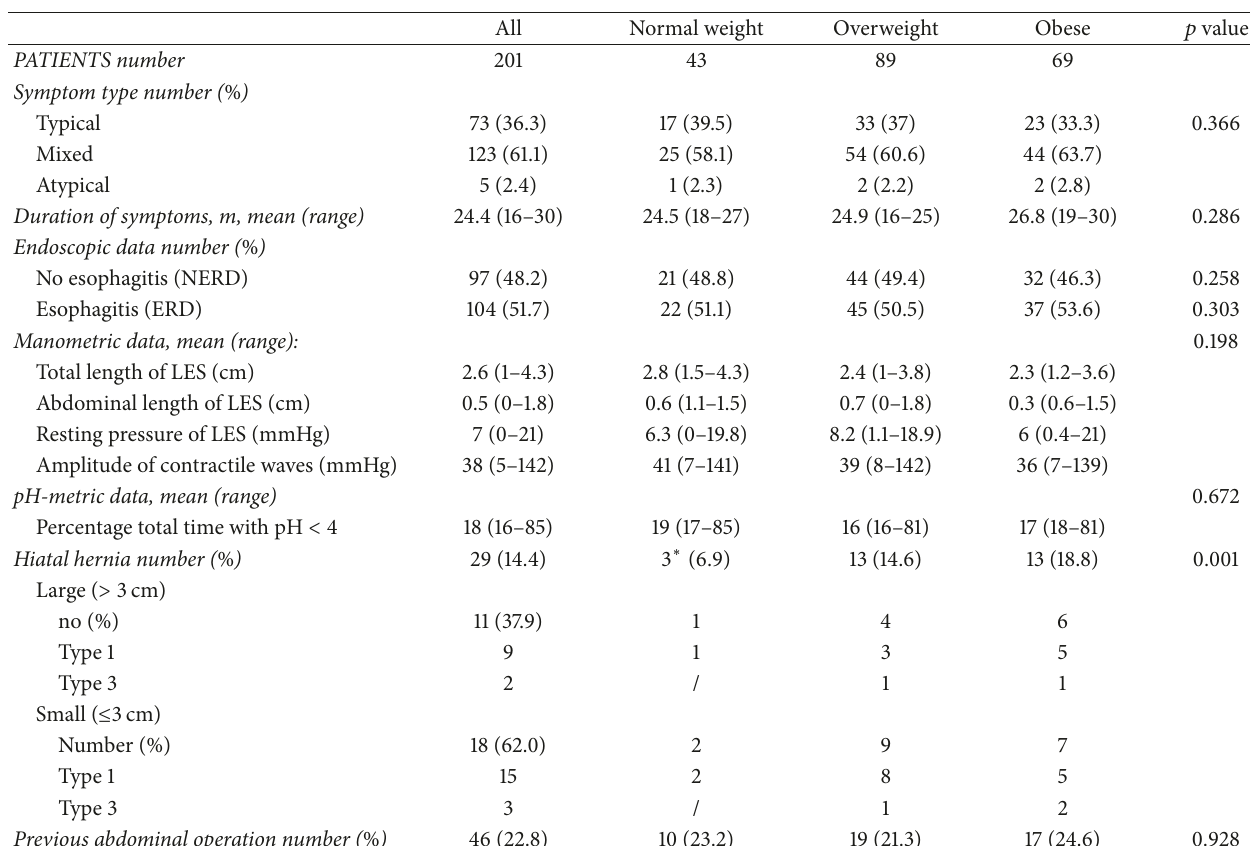
Table 2: Preoperative patient